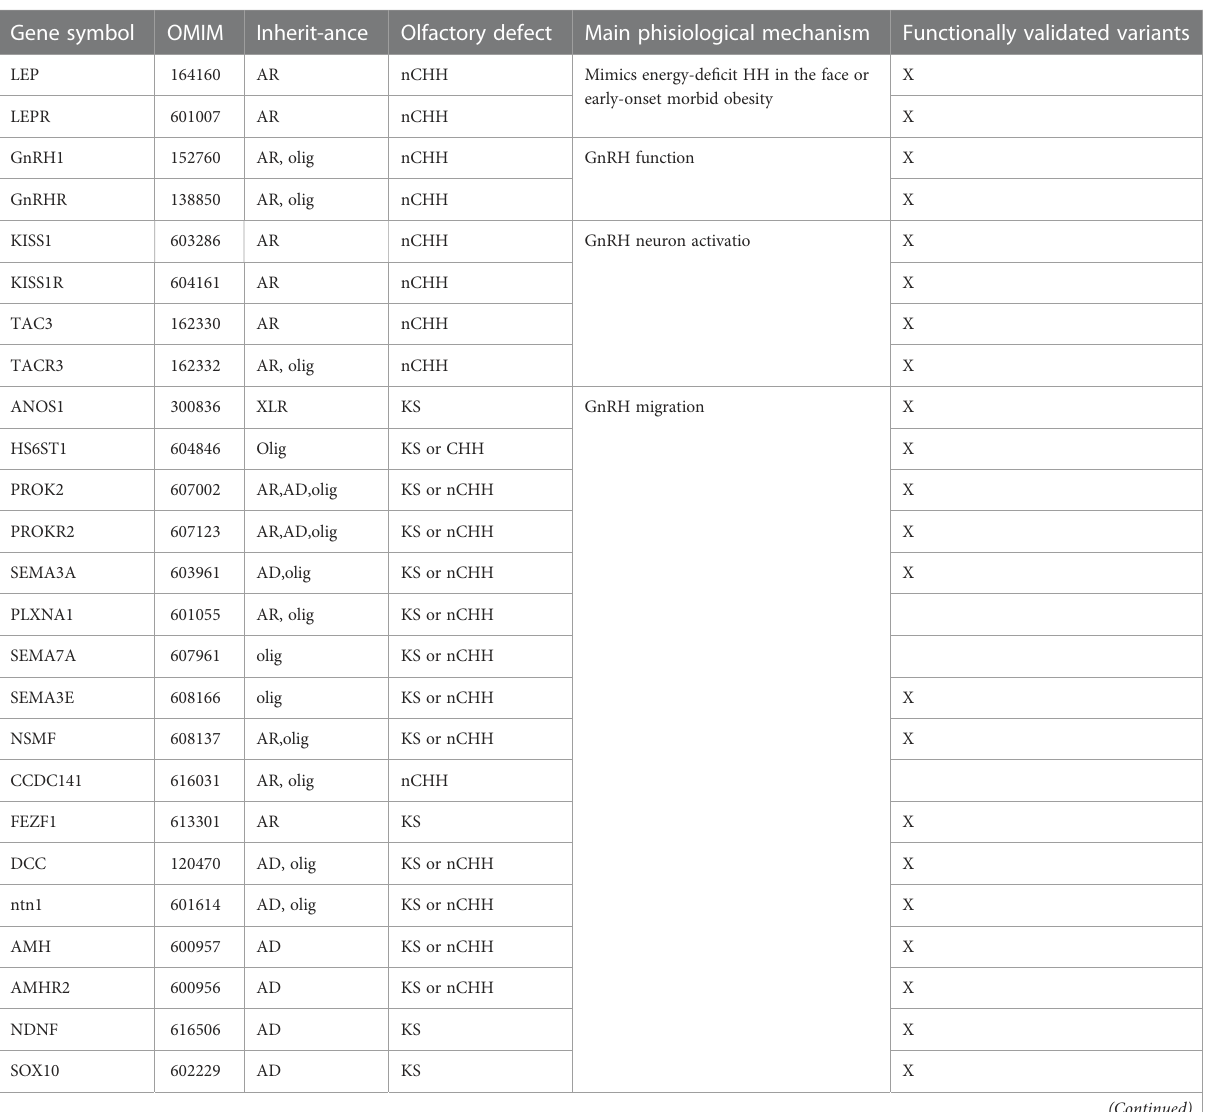
TABLE 2 List of genes implicated in CHH. Gene symbol OMIM Inherit-ance Olfactory defect Main phisiological mechanism Functionally validated